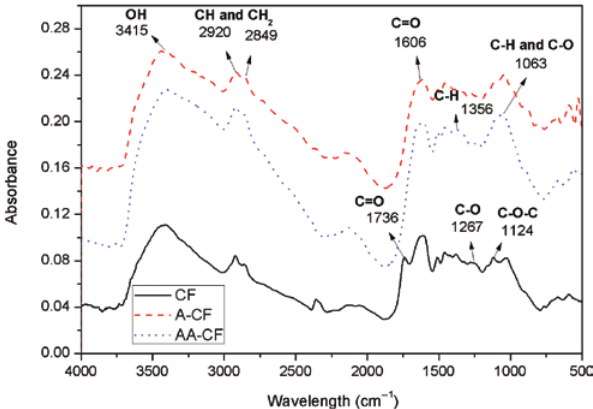
Figure 2: FTIR spectra of the coir fibers: untreated (CF), alkali-treated (A-CF), and acrylic acid-treated (AA-CF).